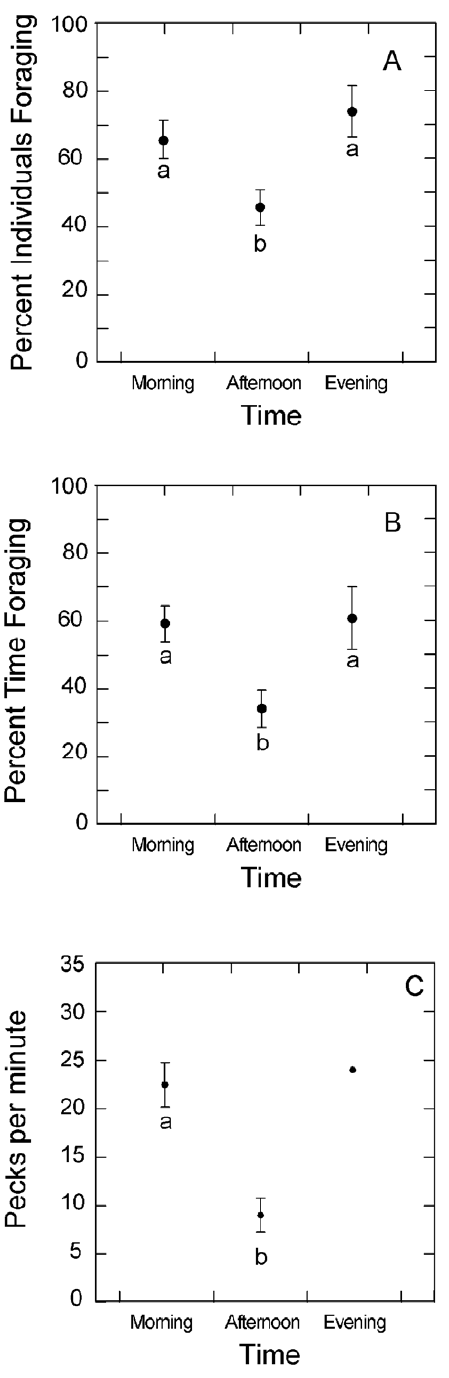
Figure 1. Foraging activity of Buff-breasted Sandpipers changed with the time of day. The mean ( 6 SE) percent of individuals observed foraging during flock scan samples (Fig. 1A) and the percent of time individuals foraged during focal observations (Fig. 1B) were lower during the afternoon (from 1200 to 1800 h) than in the morning or evening (0600 to 1200 h and 1800 to 2200 h). The intensity of feeding, as measured by the number of pecks per minute while foraging (Fig. 1C), was significantly lower in the afternoon than in the morning ( t =4.46, df=7, P =0.0043; only one observation was available during the evening time period). Means that share a letter are not significantly different using a post-hoc Tukey PLSD test.